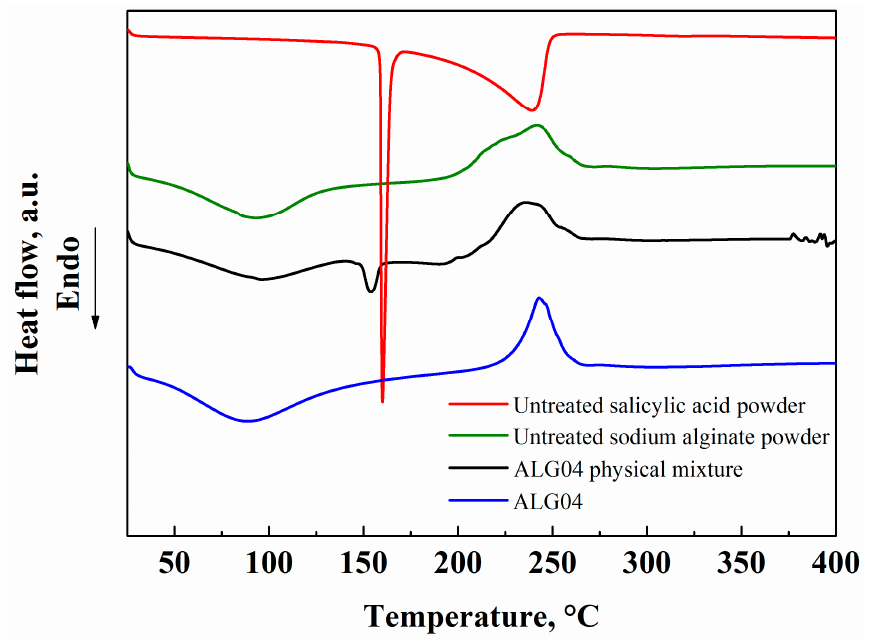
Figure 6. DSC analyses of sodium alginate (green) and salicylic acid (red) untreated powders, sodium alginate and salicylic acid untreated powders mixed in a 1/4 weight ratio (black), and loaded microparticles produced via SAA (blue).